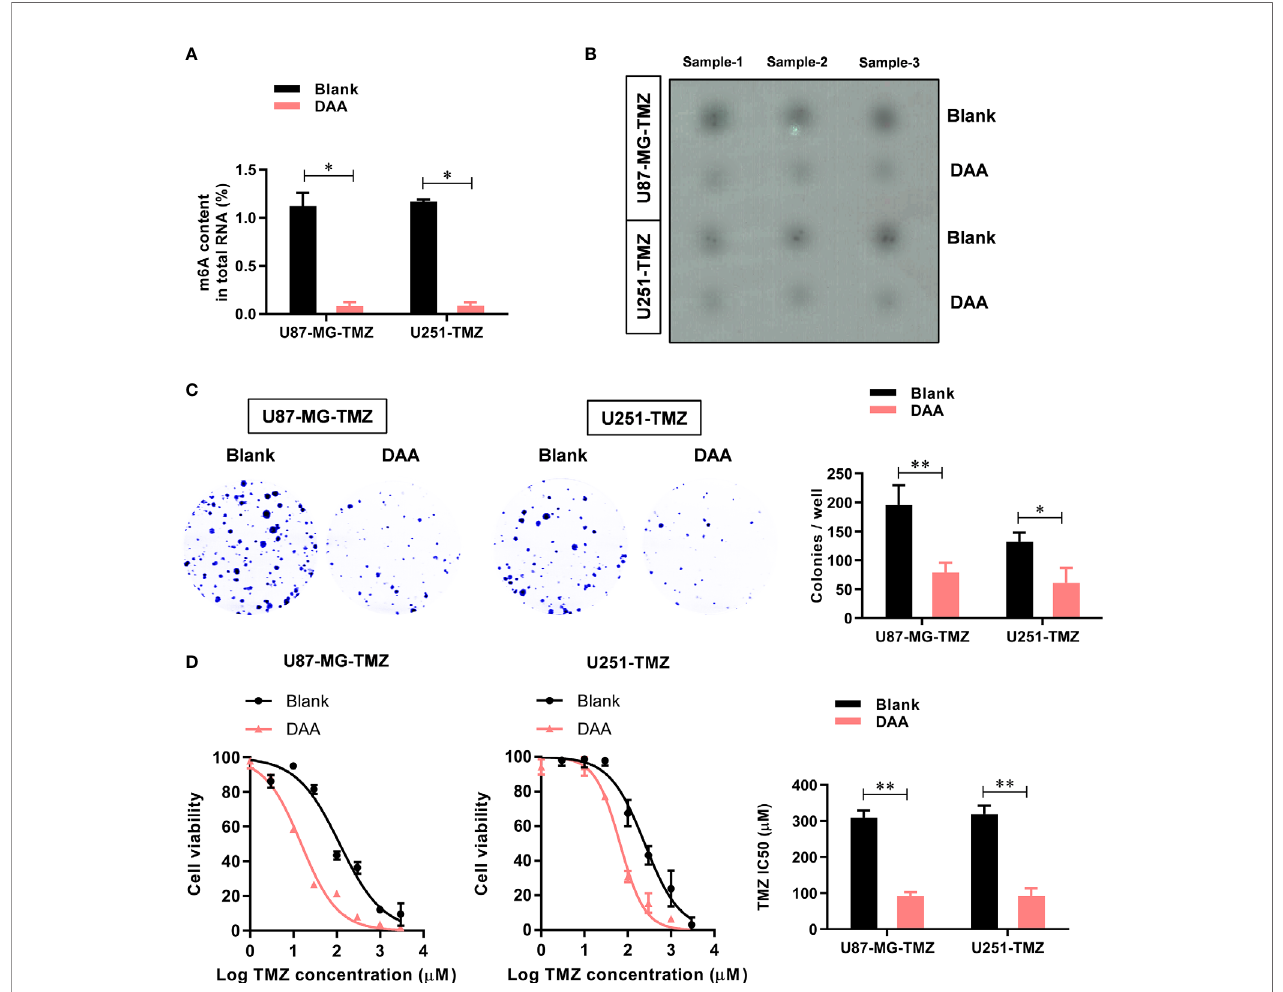
FIGURE 3 | METTL3-mediated m 6 A modi fi cation contributes to the TMZ resistance. (A) The colorimetric m 6 A quanti fi cation assay was used to examine the total m 6 A levels in the control or DAA-treated U87-MG/U251-TMZ cells. (B) The dot blot was used to con fi rm the total m 6 A levels in the control or DAA-treated U87-MG/ U251-TMZ cells. (C) The effect of DAA treatment on the cell proliferation was analyzed by the colony formation assay. (D) The effect of DAA treatment on the sensitivity to TMZ was analyzed by CCK-8 assay. * P < 0.05 and ** P < 0.01 versus blank U87-MG/U251